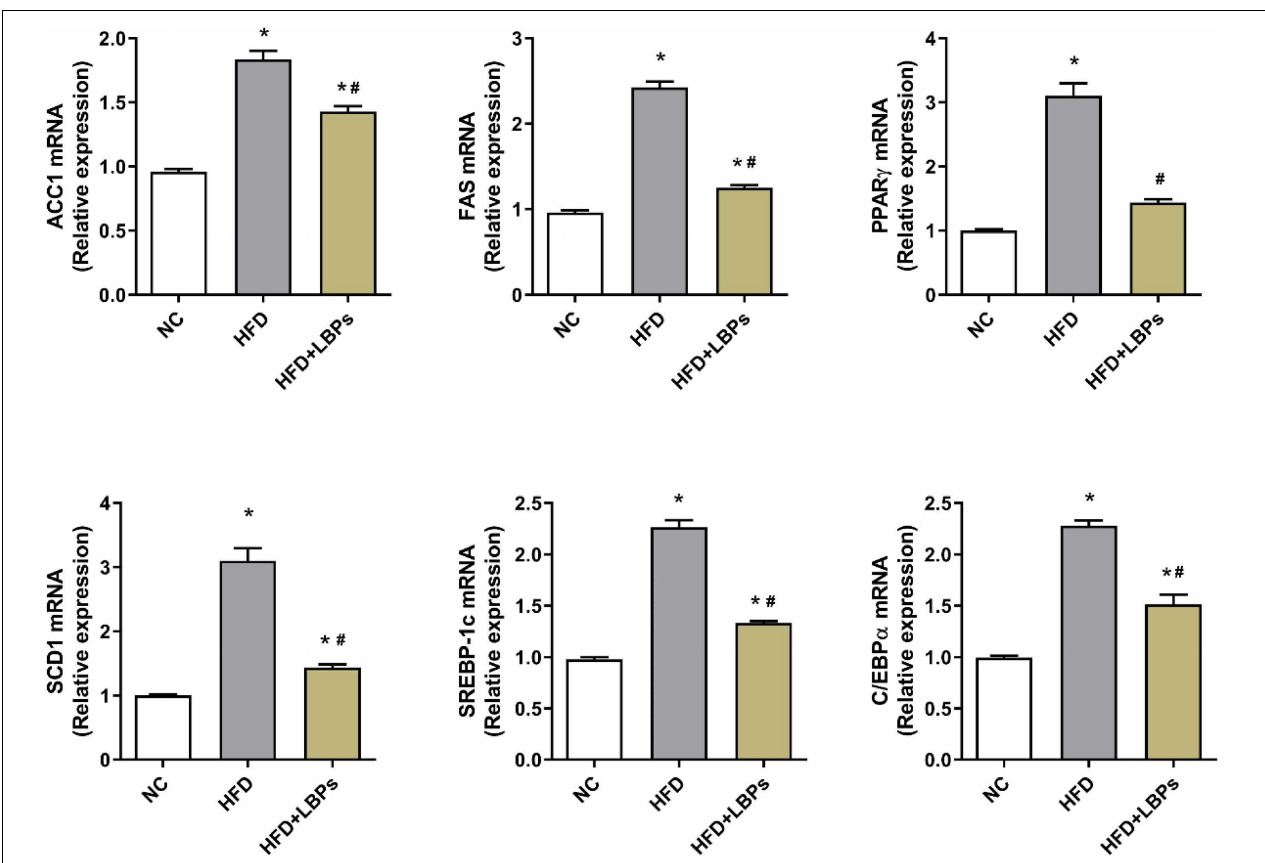
FIGURE 4 | Effects of Lycium barbarum polysaccharides (LBPs) on expression of lipid-related genes (ACC1, FAS, PPAR γ , SCD1, SREBP-1c, and C/EBP α ) in epididymal adipose tissues in HFD-fed mice. * P < 0.05 vs. NC group and # P < 0.05 vs. HFD